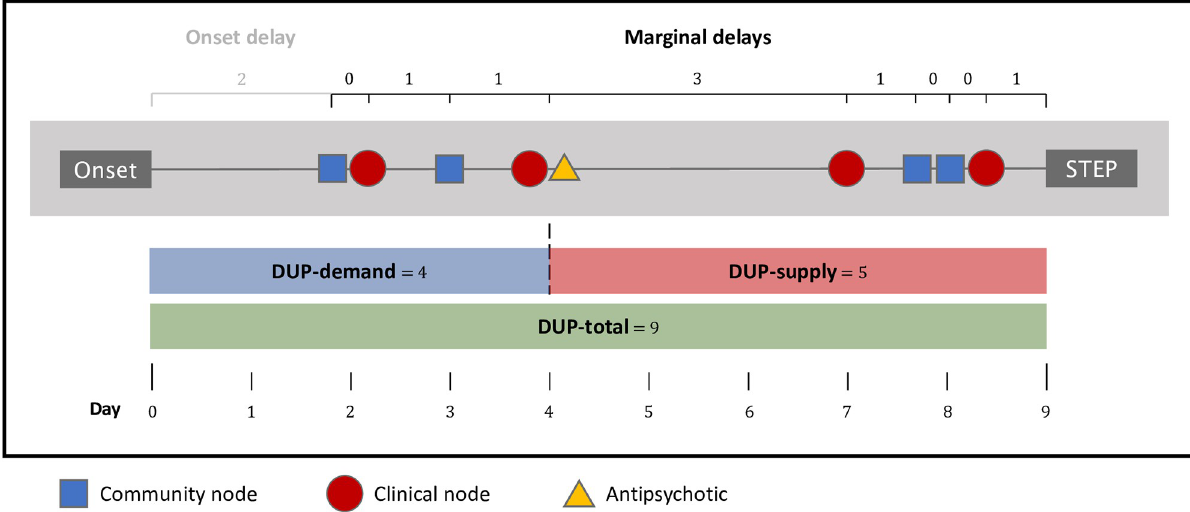
Fig 1. Conceptual and analytic model of Pathway to Care (PTC) with example values. This figure depicts the pathway to care described by the following narrative (durations are shorter than sample data for illustrative purposes): Peter began experiencing concerning auditory hallucinations on Day 0 (Onset). Two days later, his mother observes him responding to internal stimuli (first community node) and takes him to an urgent care clinic (first clinical node) the same day. They recommend watchful waiting and outpatient follow up. The next day, Peter is more bothered with the hallucinations and makes an appointment for himself (second community node) at an urgent care psychiatric service the next day. On that visit on Day 4 (second clinical node), Peter is prescribed an antipsychotic to help with his symptoms and an appointment is made for an outpatient psychiatrist, whom he sees 3 days later (third clinical node). On Day 8, Peter’s father observes increasingly concerning behaviors (third community node) and takes him to see a youth counselor at their church (fourth community node) who recommends taking him to the local Emergency Department, which they do (fourth clinical node). The ED refers Peter to STEP and he is enrolled the next day, Day 9 (STEP). DUP-total : Duration of Untreated Psychosis. DUP-demand : Demand-side duration of untreated psychosis, number of days from Onset until antipsychotic. DUP-supply : Supply-side duration of untreated psychosis, number of days from antipsychotic until STEP. Onset : Onset of psychosis, as ascertained by POPS criteria on the SIPS scale. STEP : Enrollment in Specialized Treatment Early in Psychosis clinic. Onset delay : Time in days from onset of psychosis first help-seeking node. Marginal- delay : Time in days until the next